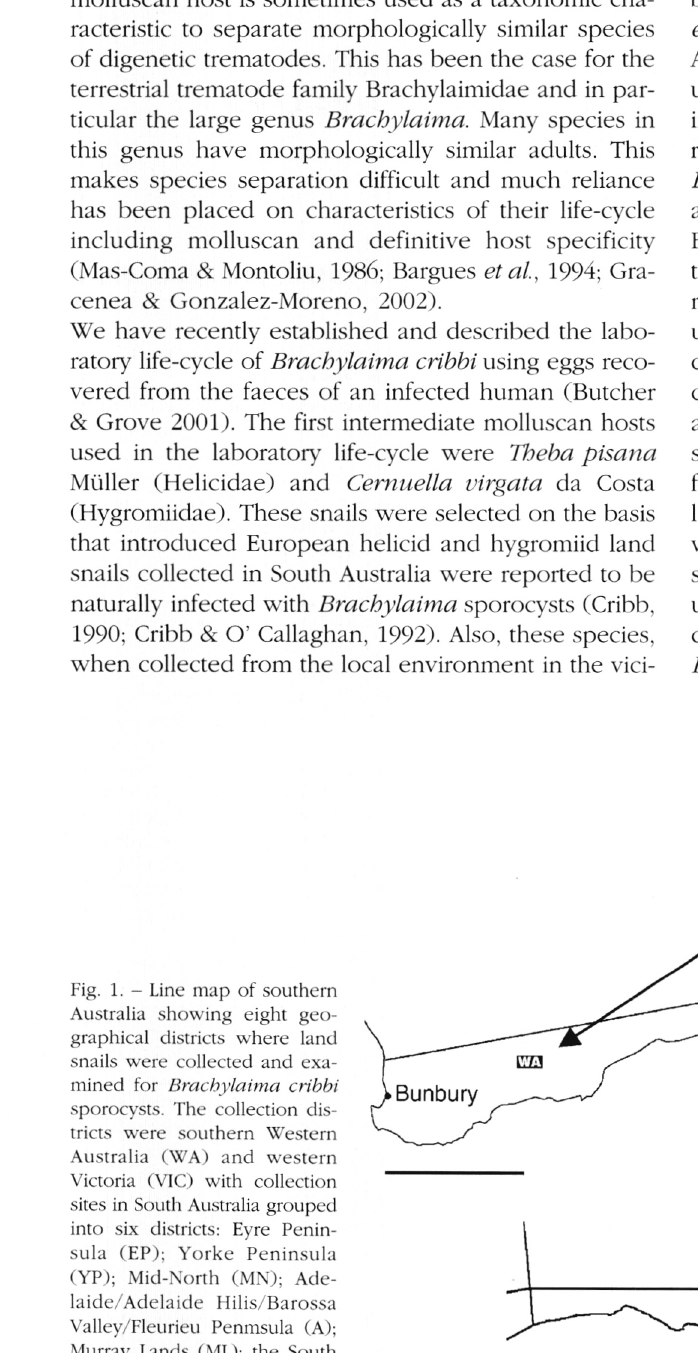
Fig. 1. - Line map of southern Australia showing eight geo­ graphical districts where land snails were collected and exa­ mined for Brachylaima cribbi sporocysts. The collection dis­ tricts were southern Western Australia (WA) and western Victoria (VIC) with collection sites in South Australia grouped into six districts: Eyre Penin­ sula (EP); Yorke Peninsula (YP); Mid-North (MN); Ade­ laide/Adelaide Hilis/Barossa Valley/Fleurieu Penmsula (A); Murray Lands (ML); the South East (SE). Bars = 500